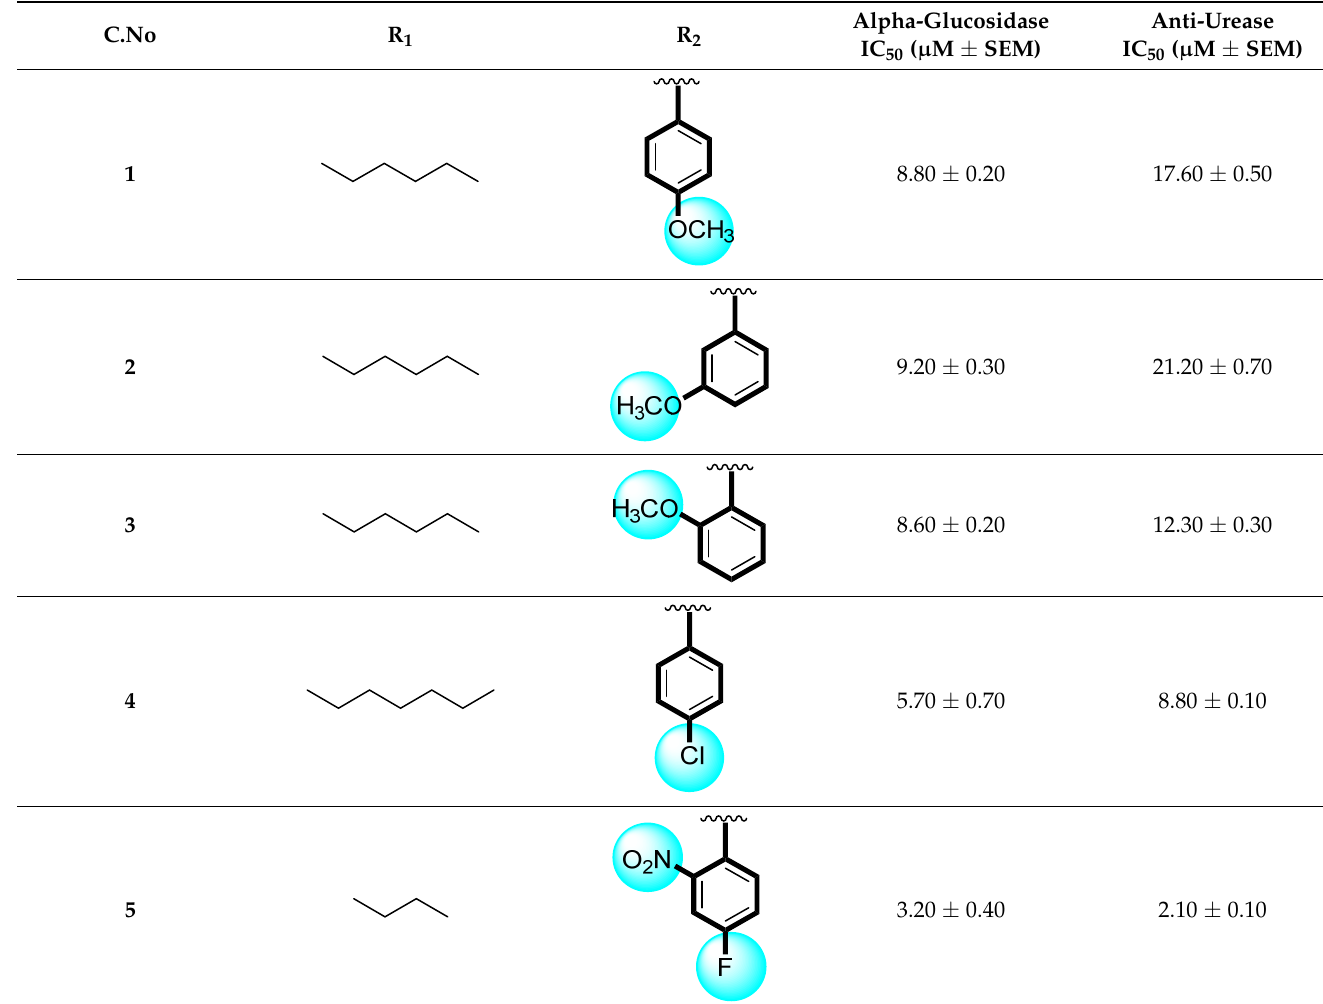
Table 1. Different substituted sulphonamide derivatives with inhibitory profile ( 1 – 15